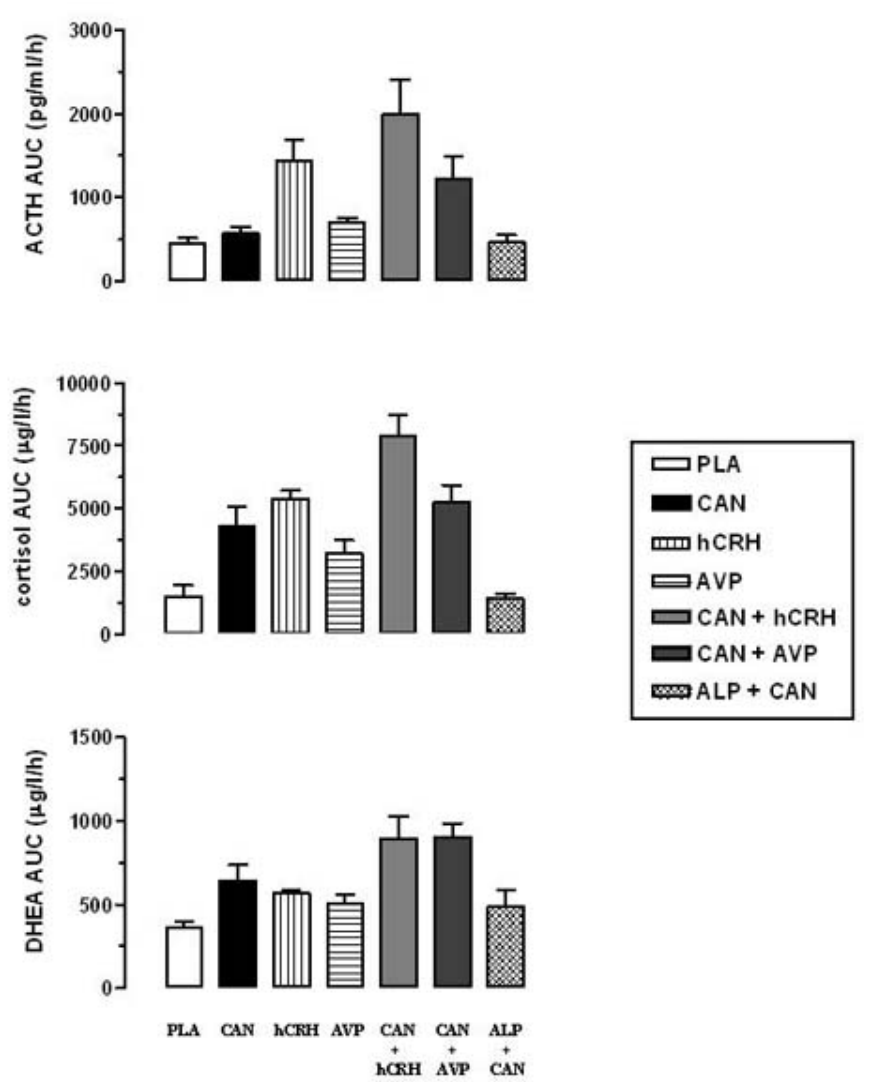
FIGURE 2. ACTH, cortisol, and DHEA responses (AUCs, mean ± SEM) to placebo, canrenoate (CAN, 200 mg as i.v. bolus + 200 mg as i.v. infusion from 2000–2400 h), hCRH (2.0 µg/kg i.v. at 0 min), AVP (0.17 U/kg i.m. at 0 min), CAN + hCRH, CAN + AVP, or CAN + alprazolam (ALP, 0.02 mg/kg p.o. at –90 min) in normal